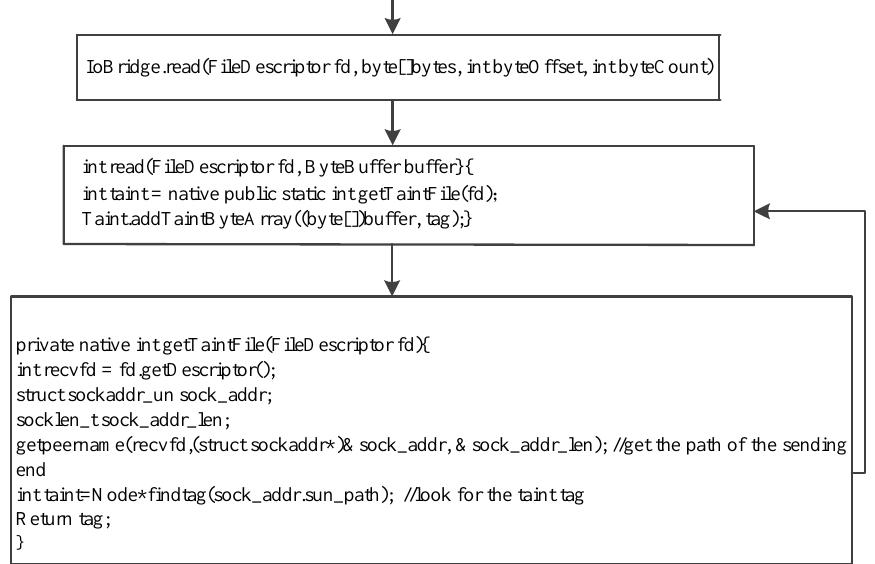
Figure 10. The “recvfrom” and “recvmsg” methods.